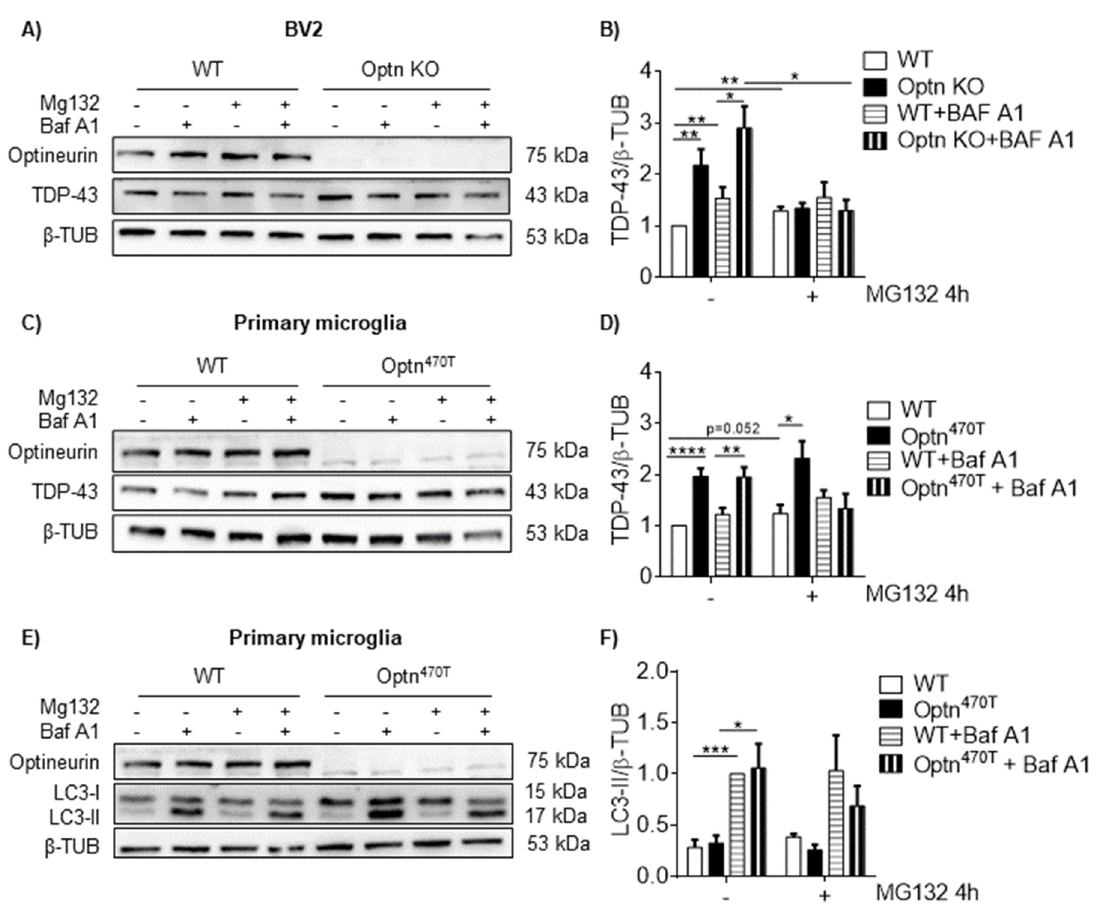
Figure 3. TDP-43 protein accumulation in BV2 Optn KO and Optn 470T primary microglia is not caused by a block in autophagy or UPS. ( A ) Western blotting for TDP-43 and optineurin in WT and Optn KO microglial cell lines treated with MG132 and BafA1 for 4 h. ( B ) Bar charts show the densitometric analysis of TDP-43 protein levels normalized to β -tubulin in microglial cells. An average ± SEM from 9 (without MG132) and 4 (with MG132) independent experiments are shown. ( C ) Western blotting for TDP-43 and optineurin in WT and Optn 470T primary microglia treated with MG132 and BafA1 for 4 h. ( D ) Bar charts show the densitometric analysis of TDP-43 protein levels normalized to β -tubulin in primary microglia. An average ± SEM from 9 (without MG132) and 4 (with MG132) independent experiments are shown. ( E ) Western blotting for LC3-I, LC3-II, and optineurin in WT and Optn 470T primary microglia treated with MG132 and BafA1 for 4 h. ( F ) Bar charts show the densitometric analysis of LC3-II protein levels normalized to β -tubulin in primary microglia. An average ± SEM from 3 independent experiments is shown. Statistical analysis was performed by Student’s t -test: * p < 0.05, ** p < 0.01, *** p < 0.001, **** p <